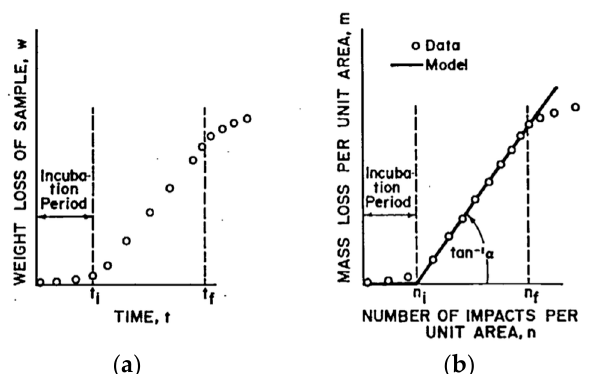
Figure 11. ( a ) Representative evolution of weight loss on experimental rain erosion testing samples, from [23]; ( b ) lifetime prediction model defining the incubation period and mass removal rate.